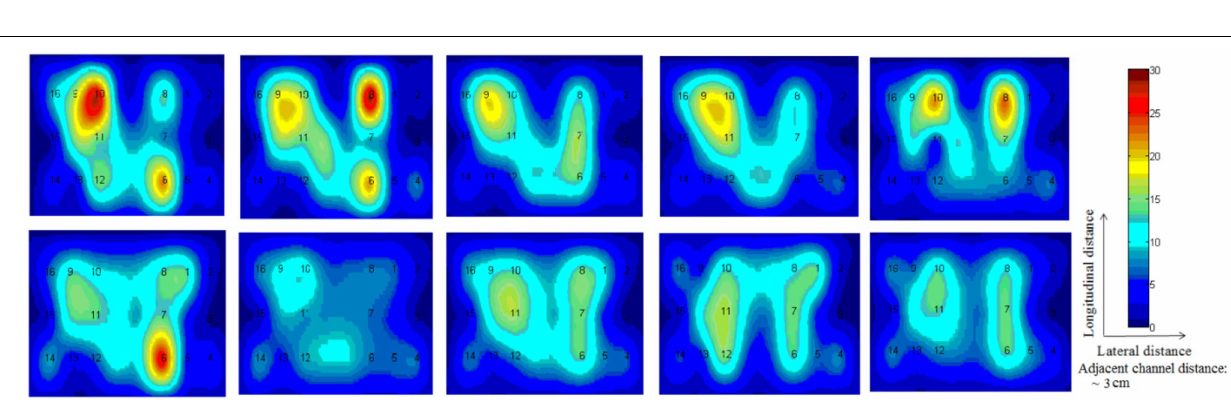
FIGURE 5 | Results of estimated HRF related to most active channel corresponding to all subjects.